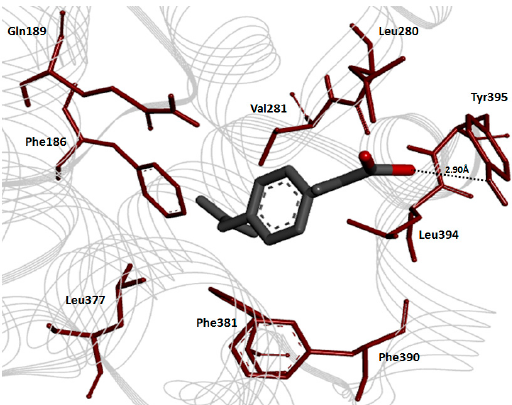
Figure 7. Docking interactions of dexibuprofen with receptor. The COX-2 protein chain is highlighted in light grey color in wire format. The dark grey color showed the dexibuprofen structure while the embedded red colors showed oxygen moiety. The binding pocket interacted residues are highlighted in dark red color and black dotted lines justify the hydrogen bondings.